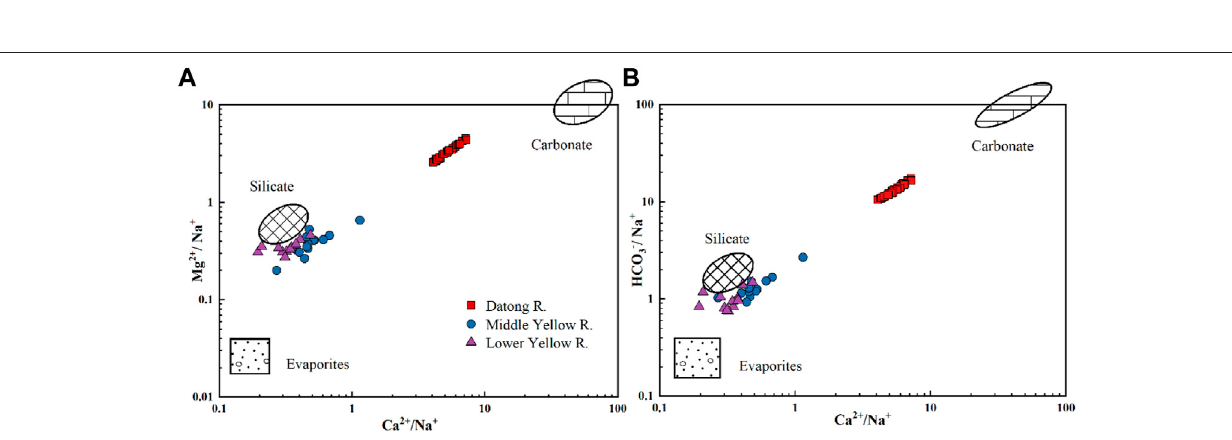
FIGURE7| Elementalratios ofCa 2+ /Na + vs.Mg 2+ /Na + and Ca 2+ /Na + vs. HCO 3 − /Na + ofriverwaterintheDatongRiver.Theendmembervaluesarefrom Gaillardet et al. (1999). The middle reaches data (Longmen) come from Zhang et al. (2015). The downstream data (Lijin) come from Ran et al. (2015).